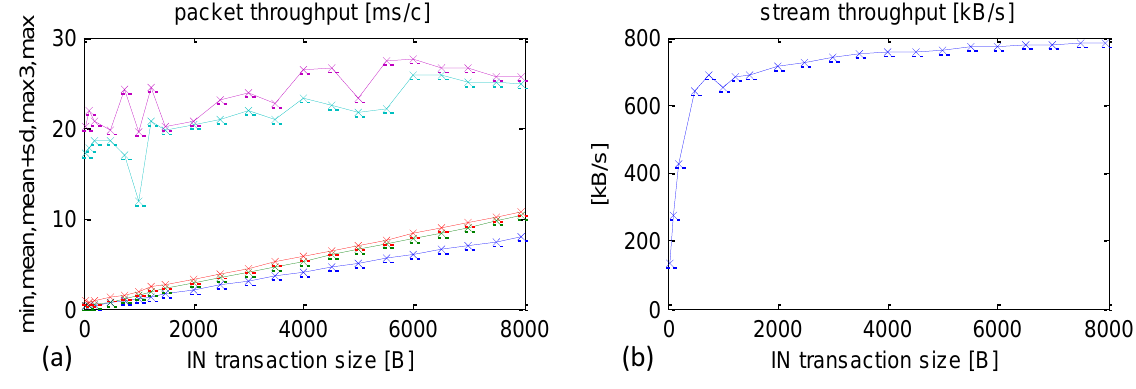
Figure 11. Experimental results after the optimisation. Maximum priority set using Java environment functions. ( a ) min, mean, mean + SD, max3, max CCLT depending on packet size. ( b ) Sensors datastream depending on packet size.